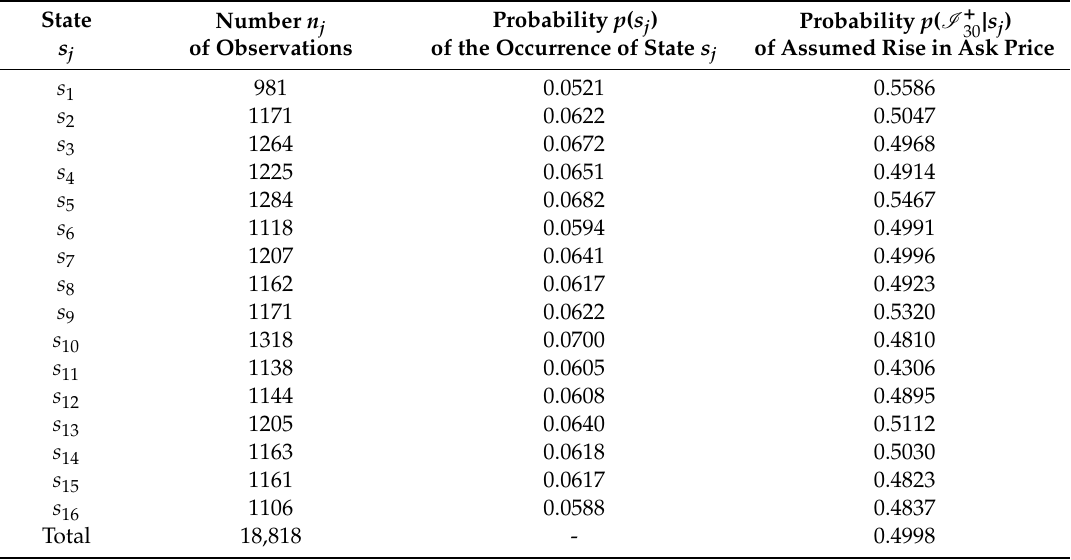
Table 3. Prediction table P ( XAU/USD,30, E 4 , Ξ 2 , Ψ 2 )